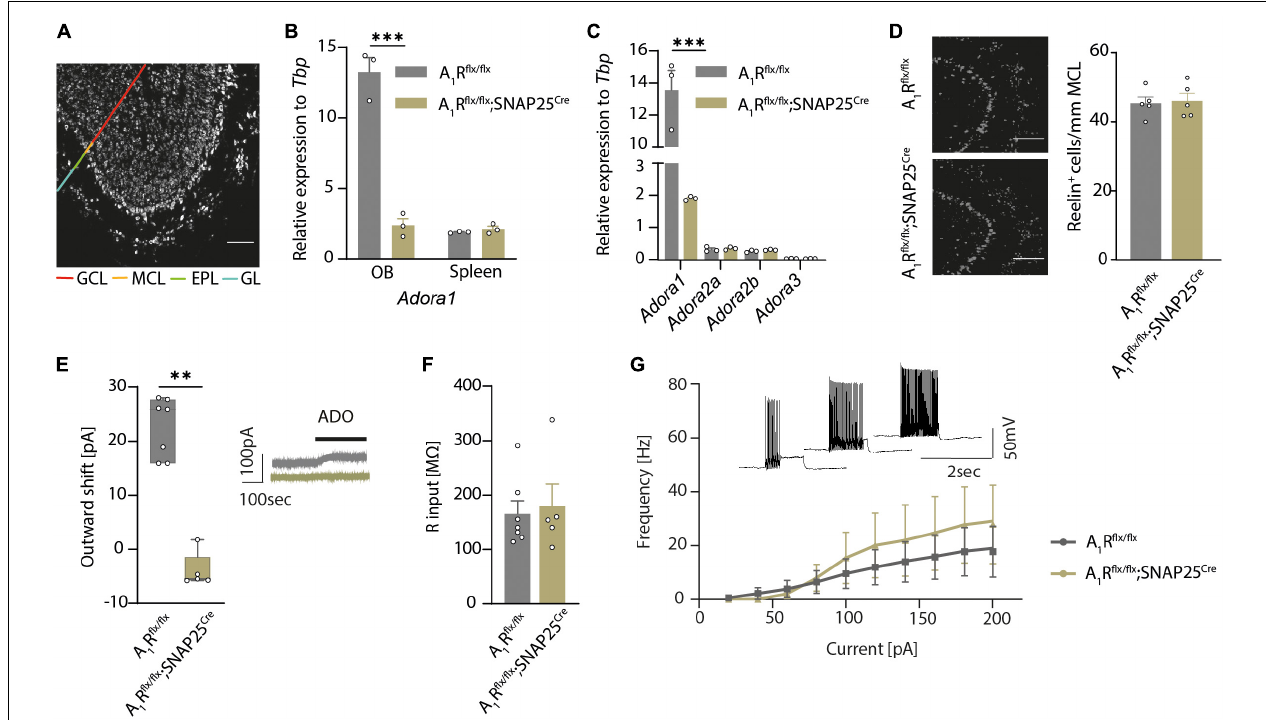
FIGURE 1 | A 1 R flx / flx ;SNAP25 Cre results in neuron-specific A1R knockout. (A) HA-tagged reporter expression in neuron-specific A 1 R knockout mouse line A 1 R flx / flx ;Tag;SNAP25 Cre indicates wide distribution of Cre expression in the main olfactory bulb. Representative image shows a sagittal view of the main olfactory bulb comprising the granular cell layer (GCL), internal plexiform layer (not marked), mitral cell layer (MCL), external plexiform layer (EPL), and the glomerular layer (GL) as indicated by different colors. HA-tag was stained with anti-HA antibody. (B) Quantitative qPCR of Adora1 (coding for the A 1 R) mRNA expression of olfactory bulbs and spleens (BF 10 = 0.538) isolated from A 1 R flx / flx ( n = 3) and A 1 R flx / flx ;SNAP25 Cre ( n = 3). (C) Quantitative qPCR mRNA expression of P1 receptor genes Adora1 , Adora2a (BF 10 = 0.646), Adora2b (BF 10 = 0.624), and Adora3 (BF 10 = 0.565) in the olfactory bulb of A 1 R flx / flx ( n = 3) and A 1 R flx / flx ;SNAP25 Cre ( n = 3) mice. (D) Mitral cells analyzed by marker Reelin in the mitral cell layer in A 1 R flx / flx ( n = 5) and A 1 R flx / flx ;SNAP25 Cre ( n = 5) mice (BF 10 = 0.337). (E) Outward shift of the holding current in the mitral cell patch clamp recordings evoked by the application of 100 µ M of adenosine (ADO) in A 1 R flx / flx ( n = 7 slices from 5 mice) and A 1 R flx / flx ;SNAP25 Cre ( n = 5 slices from 4 mice) (MWU; U = 0, P = 0.0025). Representative traces in gray (A 1 R flx / flx ) and olive (A 1 R flx / flx ;SNAP25 Cre ). (F) Input resistance was measured in patch clamp recordings of mitral cells from A 1 R flx / flx ( n = 7 slices from 5 mice) and A 1 R flx / flx SNAP25 Cre ( n = 5 slices from 4 mice) mice, BF 10 = 0.486. (G) Progression of the F/I plot shows excitability of mitral cells from A 1 R flx / flx ( n = 7 slices from 5 mice) mice vs. A 1 R flx / flx ;SNAP25 Cre ( n = 5 slices from 4 mice) (BF 10 = 0.480-0.537). Data points display mean ± s.e.m. ∗∗ P < 0.01, ∗∗∗ P <